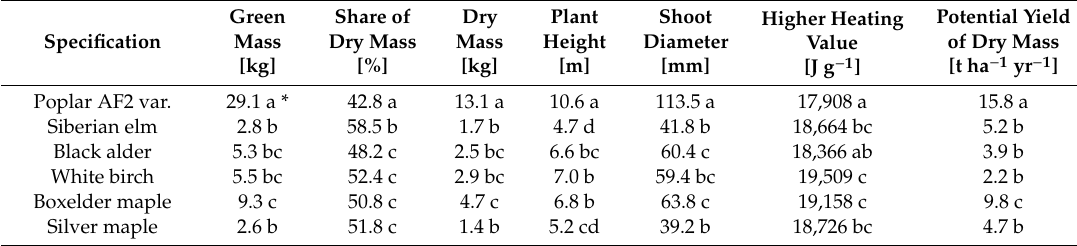
Table 2. Median values of tested plants and their biometric